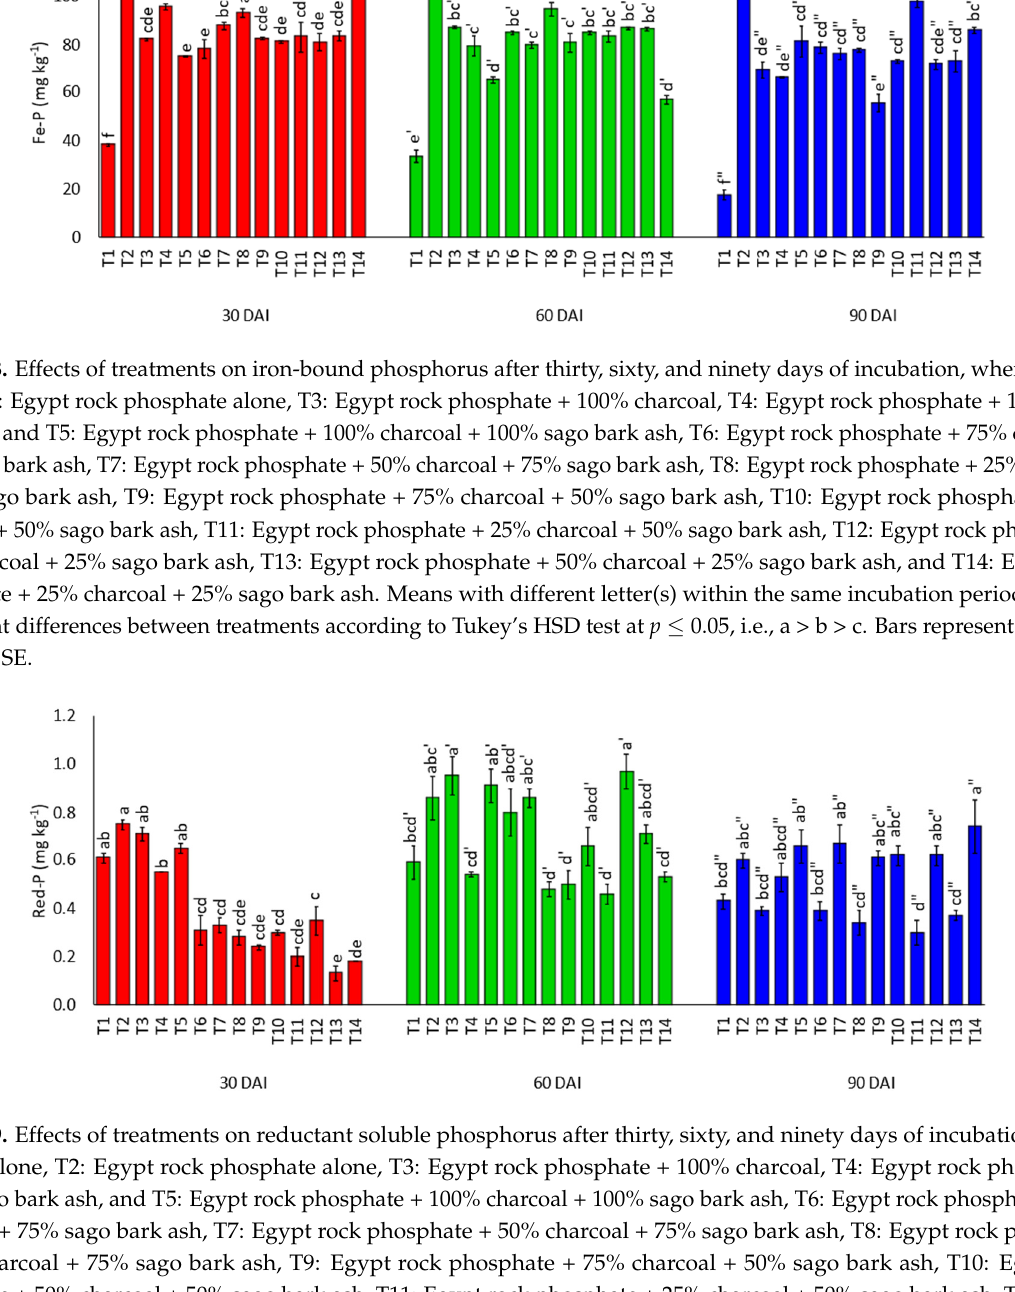
17 of 28 Figure 17. Effects of treatments on aluminium-bound phosphorus after thirty, sixty, and ninety days of incubation, where T1: soil alone, T2: Egypt rock phosphate alone, T3: Egypt rock phosphate + 100% charcoal, T4: Egypt rock phosphate + 100% sago bark ash, and T5: Egypt rock phosphate + 100% charcoal + 100% sago bark ash, T6: Egypt rock phosphate + 75% charcoal + 75% sago bark ash, T7: Egypt rock phosphate + 50% charcoal + 75% sago bark ash, T8: Egypt rock phosphate + 25% charcoal + 75% sago bark ash, T9: Egypt rock phosphate + 75% charcoal + 50% sago bark ash, T10: Egypt rock phosphate + 50% charcoal + 50% sago bark ash, T11: Egypt rock phosphate + 25% char- coal + 50% sago bark ash, T12: Egypt rock phosphate + 75% charcoal + 25% sago bark ash, T13: Egypt rock phosphate + 50% charcoal + 25% sago bark ash, and T14: Egypt rock phosphate + 25% charcoal + 25% sago bark ash. Means with different letter(s) within the same incubation period indicate sig- nificant differences between treatments according to Tukey’s HSD test at p ≤ 0.05, i.e., a > b > c. Bars represent the mean values ± SE.